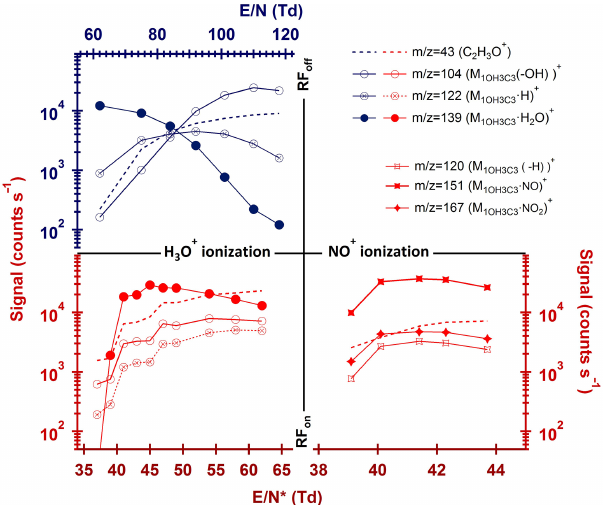
Figure 5. Recorded mass spectrum of 1OH3C3 (black bars) at the lowest extent of fragmentation of the molecular ion ( E/N = 62Td) in the H 3 O + ionization mode in absence of the RF device (a) and in the NO + ionization mode in presence of the RF ( E/N ∗ = 41Td) (b) . The thin green line represents the expected molecular ion of the analyte. The intense signals depicted by the red thin bars represent the ionizing and matrix analytes at m/z = 30 (NO + ) and ) and their isotopic abundance signals at m/z = 31 and 46 (NO + 2 47, 48 respectively. The signals corresponding to the water clusters (H 3 O + (H 2 O) n at m/z 37 and 55 are systematically erased for sim-